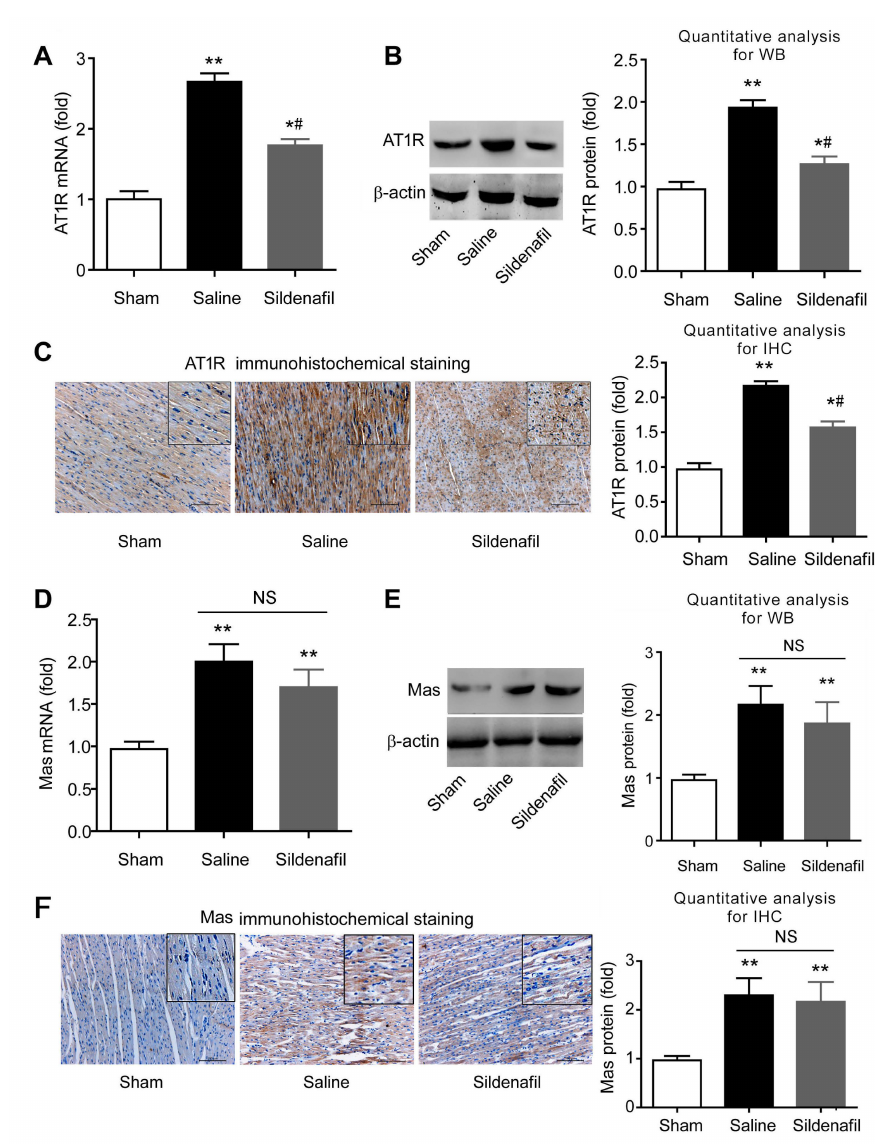
Figure 7. The expression of AT1R and Mas (mRNA and protein) after post-resuscitation in a porcine myocardial I/R injury model. Effects of sildenafil on AT1R mRNA level and protein levels were determined by qRT-PCR ( A ), Western blotting ( B ), and Immunohistochemistry ( C ) and compared to the sham and saline-treated groups. * p < 0.05 vs . Sham, ** p < 0.01 vs . Sham; # p < 0.05 vs . Saline. NS, no significance. n = 6–10 per group. Effects of sildenafil on Mas expression were measured by qRT-PCR ( D ), Western blotting ( E ), and Immunohistochemistry ( F ), and compared to the sham and saline-treated groups. * p < 0.05 vs . Sham, ** p < 0.01 vs . Sham; # p < 0.05 vs . Saline. NS, no significance. n = 6–10 per group. Scale bar in C , F : 100 µ